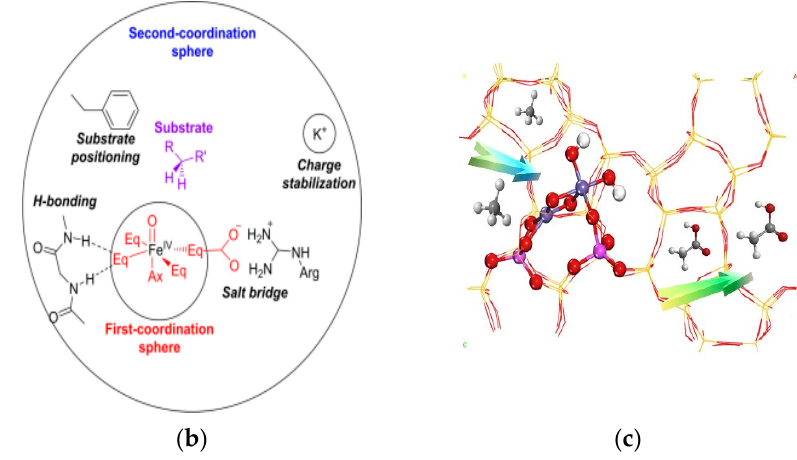
Figure 1. General performance mechanism of M-cavitin catalysts. ( a ) Crystal structure of [FeFe] hydrogenase ( Clostridium pasteurianum CpI; PDB: 4XDC), showing [FeFe]-S(Cys)-[4Fe4S] active clusters included in its cavities. Adapted with permission from (Castner et al., 2021) [109]. Copyright 2021 American Chemical Society. ( b ) Cavity effects. Reprinted with permission from (Mukherjee et al., 2021) [29]. Copyright 2021 American Chemical Society. ( c ) Conversion of methane to CH 3 COOH on [Fe III -(µO) 2 -Fe III ]-ZSM-5, the arrows show the transport of substrates in and products out. Reprinted with permission from (Wu et al., 2022) [72]. Copyright 2023 Elsevier.